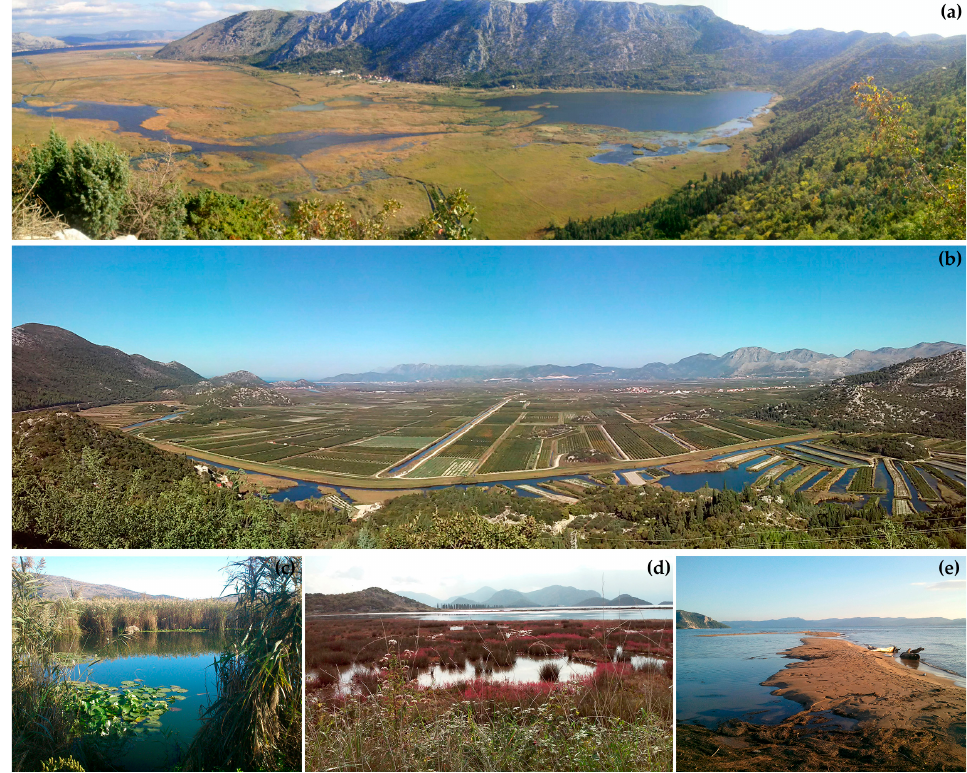
Figure 2. Neretva delta landscape ( a ) Kuti lake, ( b ) trenches landscape pattern, ( c ) reeds by the river, ( d ) Mediterranean fines of high sieves, ( e ) sandbanks at the mouth of the river Neretva.